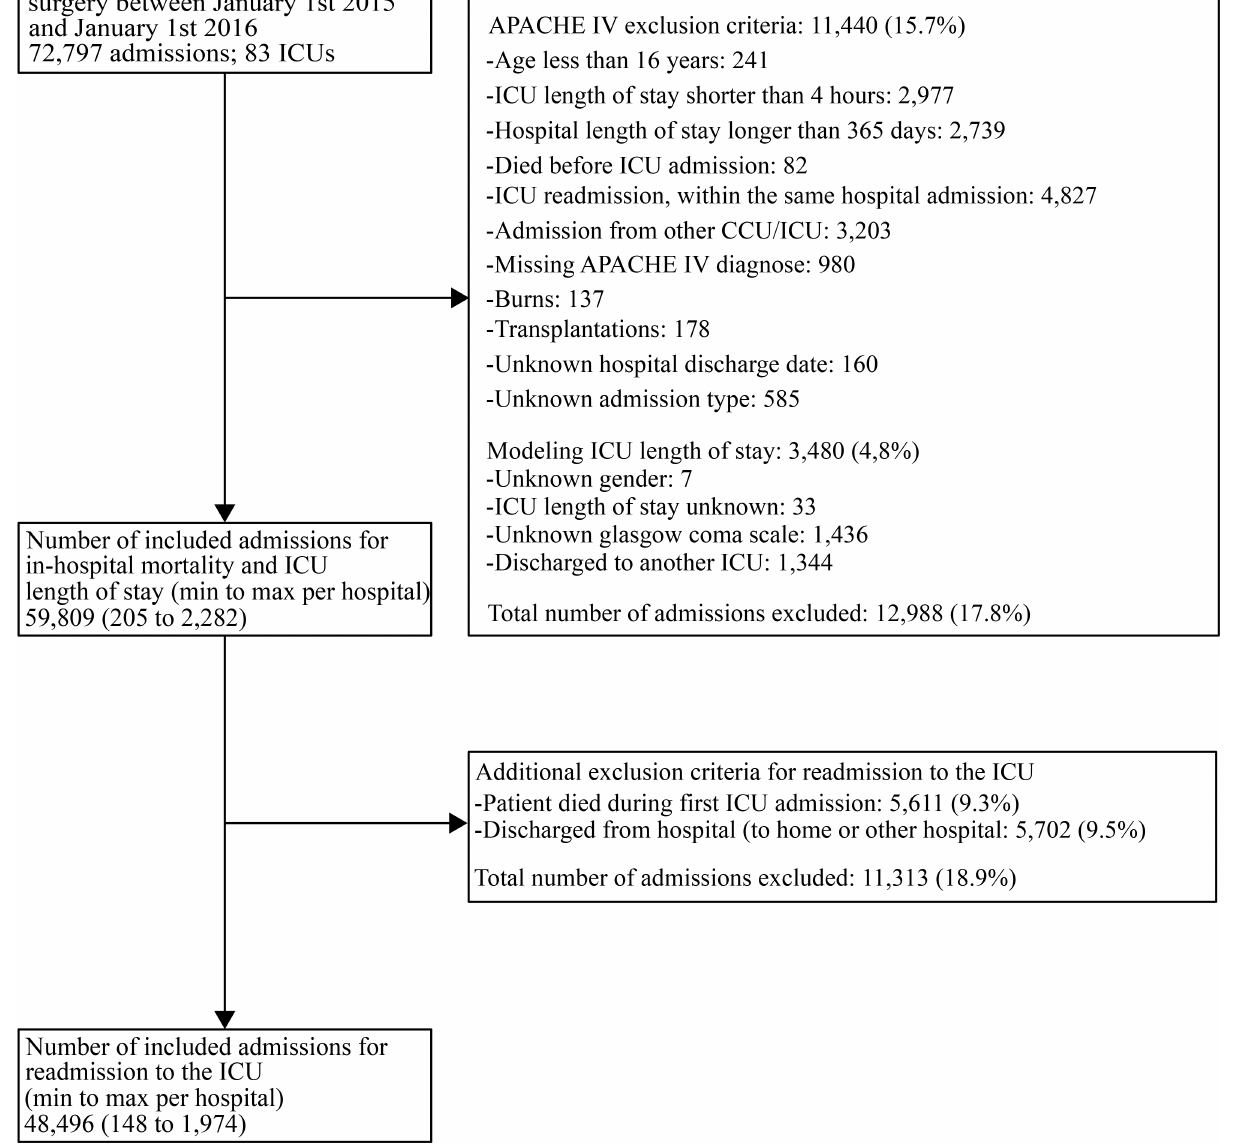
Fig 1. Flowchart of admissions included for the quality indicators for in-hospital mortality, readmission to the ICU and ICU length of